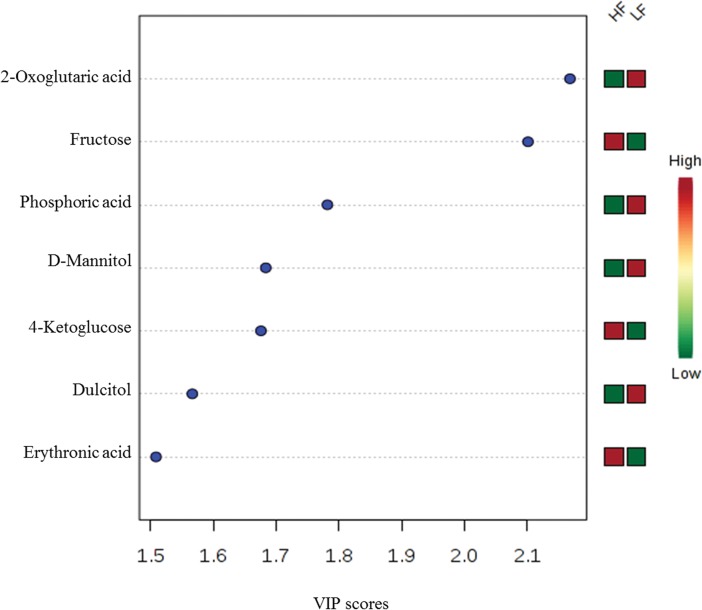
VIP scores of seminal plasma metabolites in high (HF) and low fertility (LF) bulls.The selected metabolites were those with VIP score of greater than 1.5. Heat map with red or green boxes on the right indicates high and low abundance ratio, respectively, of the corresponding metabolite in HF and LF bulls. VIP score was based on the PLS-DA model.